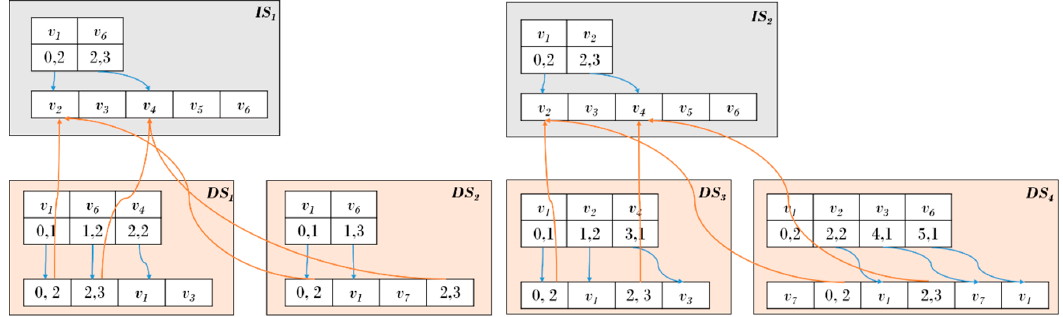
Figure 9. Historical graph search.